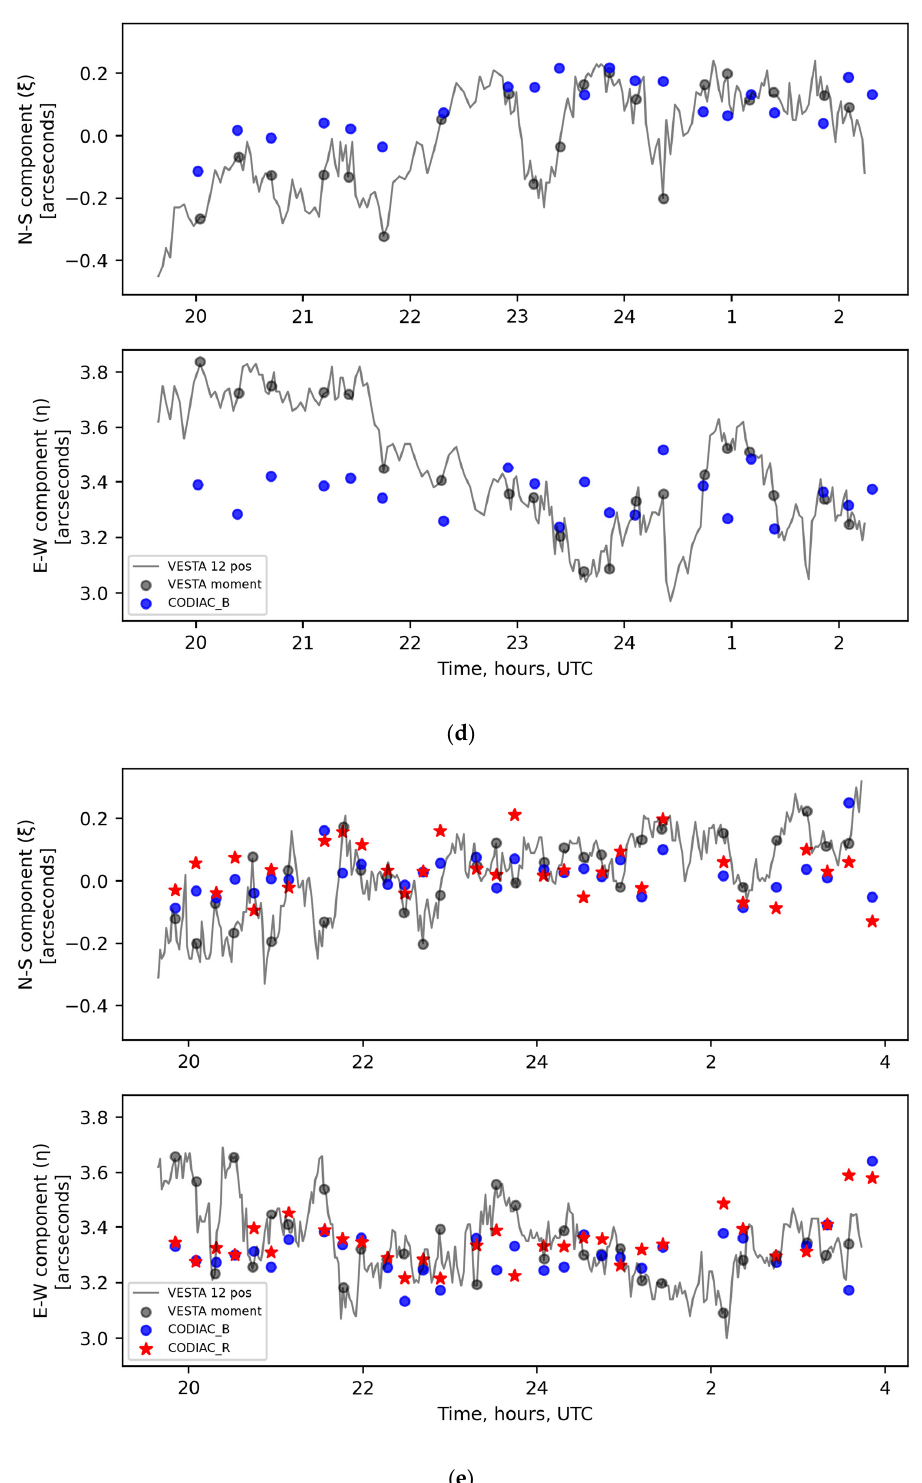
Figure 5. Time series of both deflection of the vertical (DoV) components at HEIG-VD: ( a ) 2 August 2021; ( b ) 8 August 2021; ( c ) 9 August 2021; ( d ) 10 August 2021; and ( e ) 11 August 2021. Thin grey line: VESTA 12-position (~15–18 min) time window solution; grey dots: selected individual points from VESTA time series of 12-position time window solution with time closest to individual CODIAC measurement time moments; blue dots: CODIAC Blue individual measurements; red stars: CODIAC Red individual